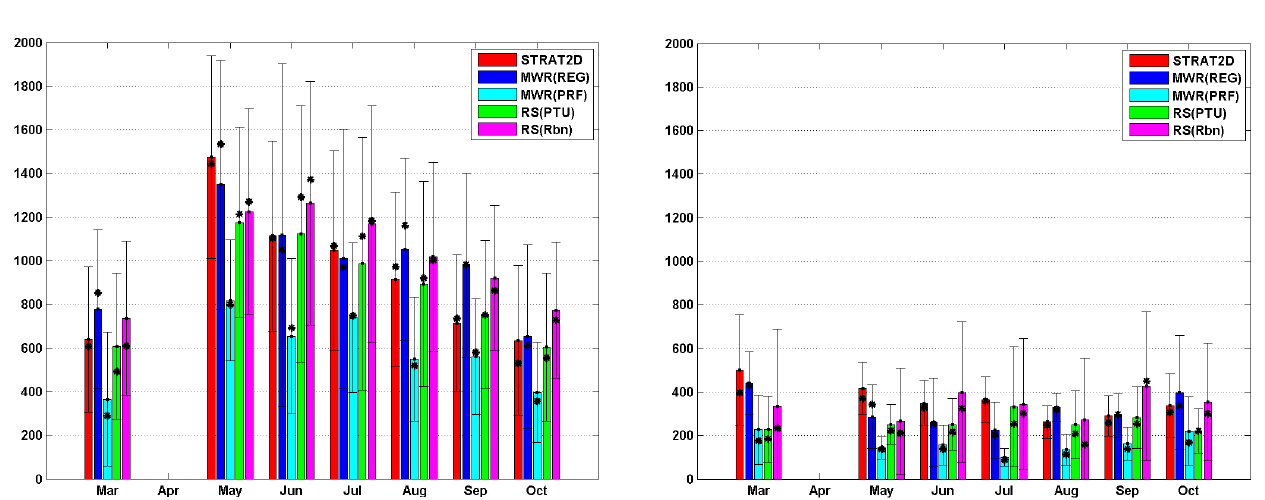
Fig. 7. As in Fig. 6 but for nocturnal MLH (ma.g.l.). Values are Figure 7: As in Figure 6 but for nocturnal MLH (m AGL). Values are taken as 1-hour average 2 taken as 1h average around around 23.30 UTC. 3